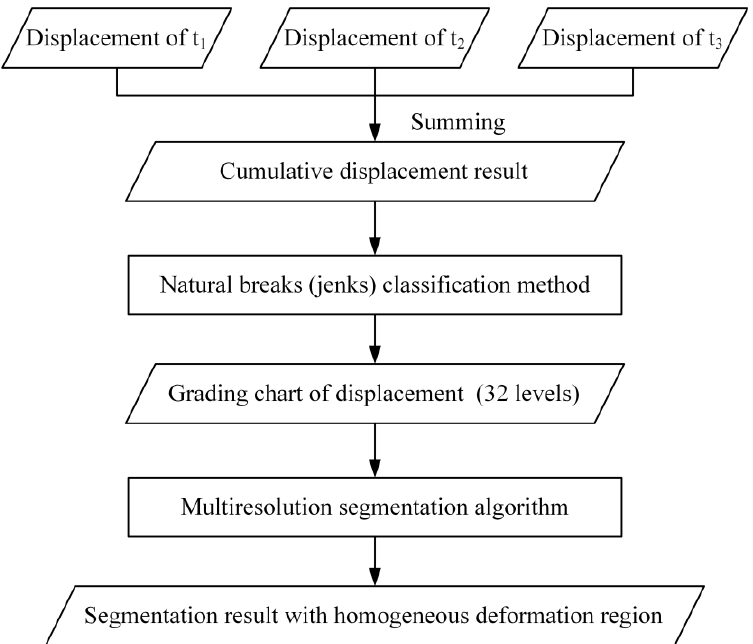
Figure 2. Flow chart of data processing for clustering interferometric synthetic aperture radar (InSAR) data using multiresolution segmentation (MRS) algorithm.